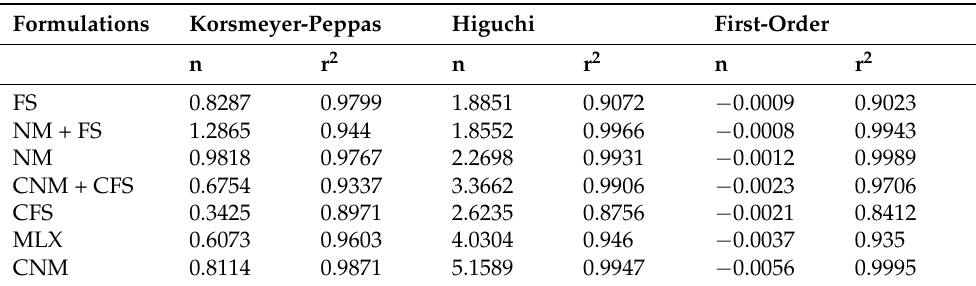
Table 2. Korsmeyer-Peppas, Higuchi, and first-order kinetic models applied for MLX release from MLX raw material and multiparticulate colonic systems CNM + CFS, CFS and CNM.